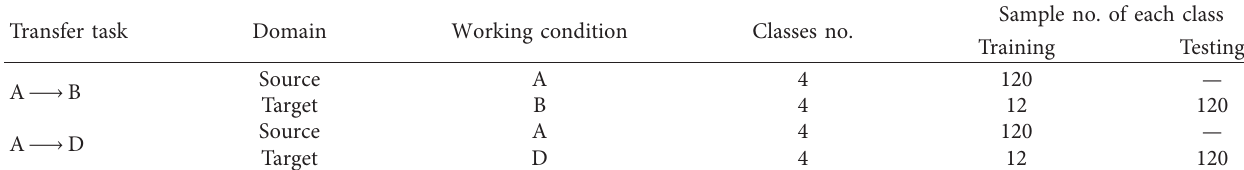
Table 4: Setting details of transfer task A ⟶ B and A ⟶ D.